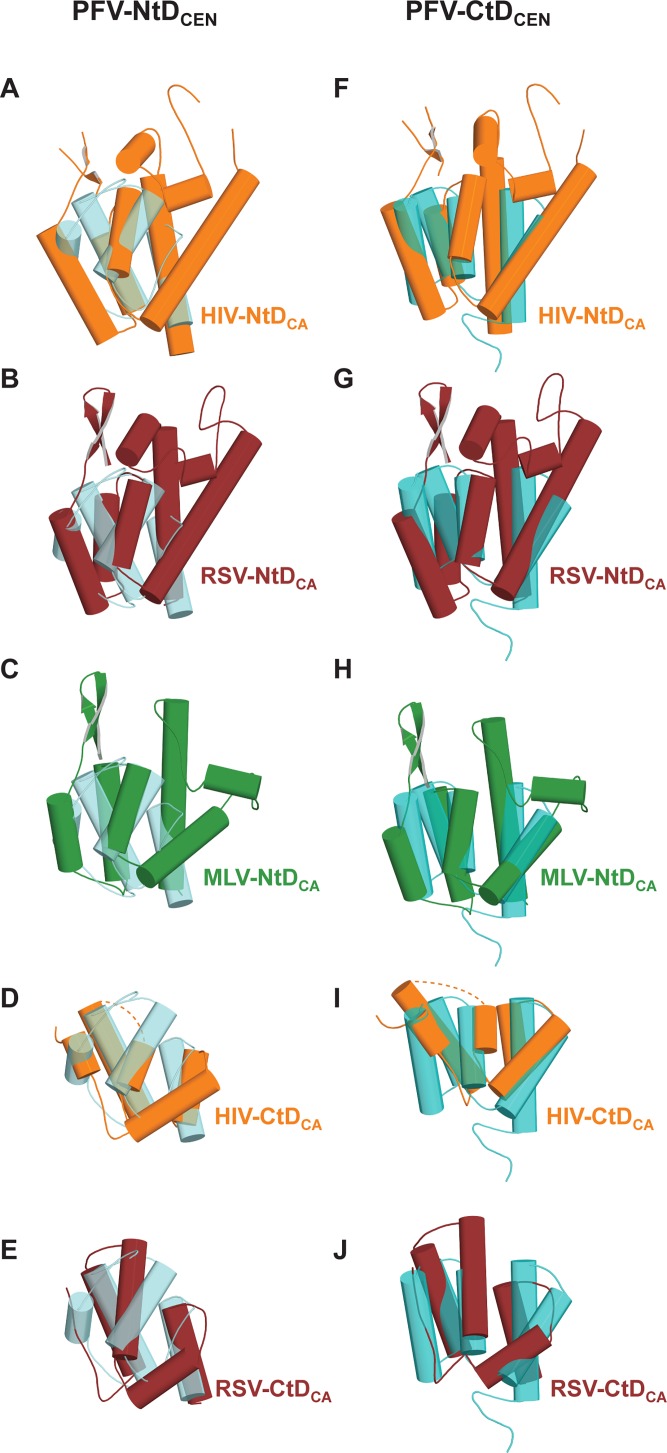
Alignment of PFVCEN domains with orthoretroviral CA proteins.Panels A-E, are best-fit 3D structural superimpositions of PFV-NtDCEN (light cyan) with (A) HIV-1 NtDCA (orange), (B) RSV NtDCA (maroon), (C) MLV NtDCA (green), (D) HIV-1 CtDCA (orange) and (E) RSV CtDCA (maroon). Panels F-J are best-fit 3D structural superimpositions of PFV-CtDCEN (dark cyan) with (F) HIV-1 NtDCA (orange), (G) RSV NtDCA (maroon), (H) MLV NtDCA (green), (I) HIV-1 CtDCA (orange) and (J) RSV CtDCA (maroon). In all panels, molecules are shown in cartoon representation with α-helices displayed as cylinders. The dashed lines in panels D and I indicate the connectivity between helices 8 and 9 of HIV-CTDCA that is disordered in the CA hexamer structures used in the alignment.